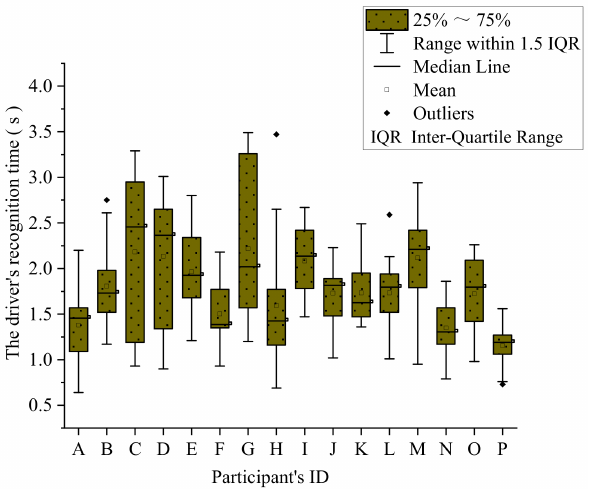
Figure 7. The box diagram of the data